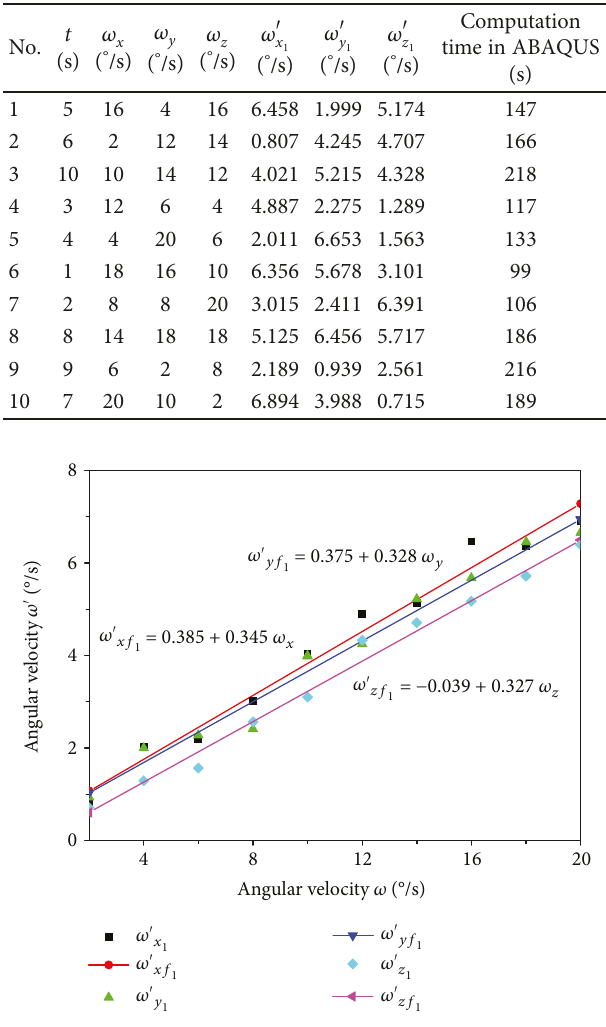
Figure 7: Fitting polynomial and fi tting results of empty storage tank for ω xf Table 9: ω